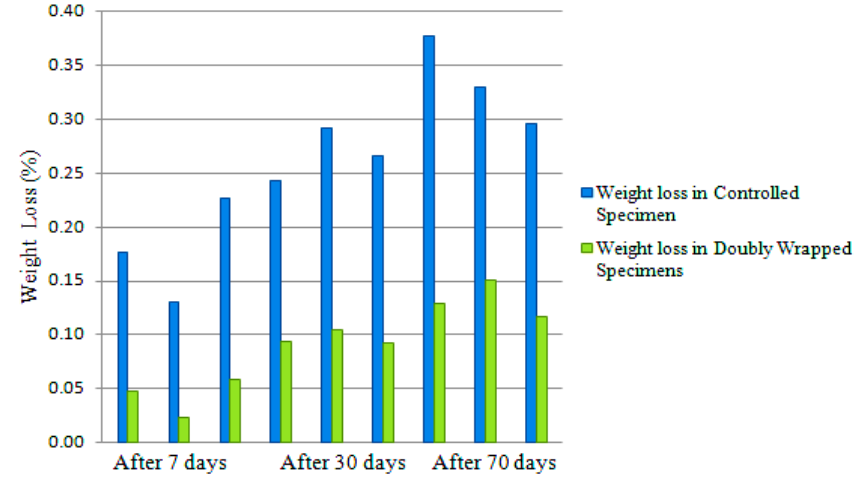
Figure 2. Compressive strength test .